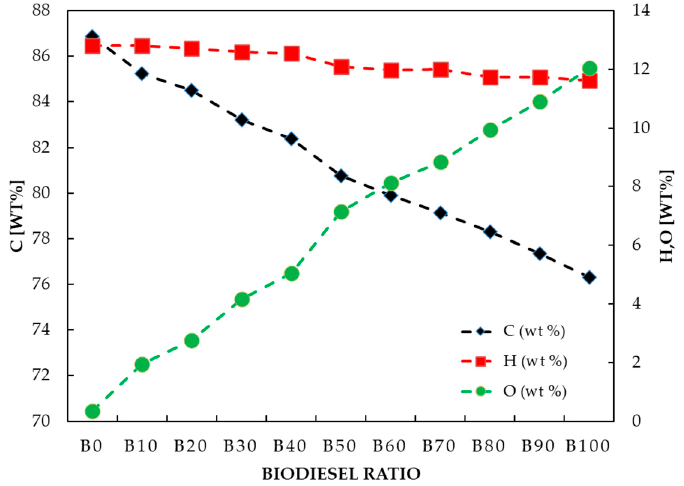
Figure 7. An effect of biodiesel ratio on the H/C and O/C ratios.